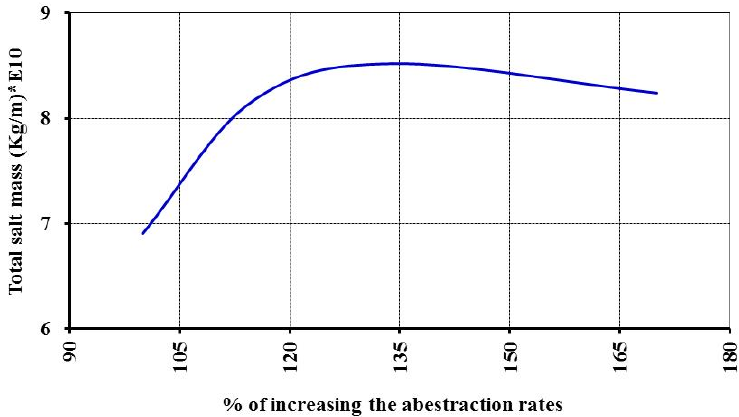
Figure 12. Relation between abstraction rate and total dissolved salt (TDS) values in the ENDA.